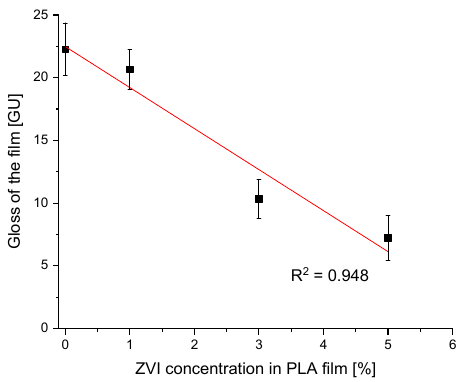
Figure 3. Gloss level of LCA films measured at the angle of 60 degrees for pure polylactide film and with the addition of zero-valent iron in different concentrations.